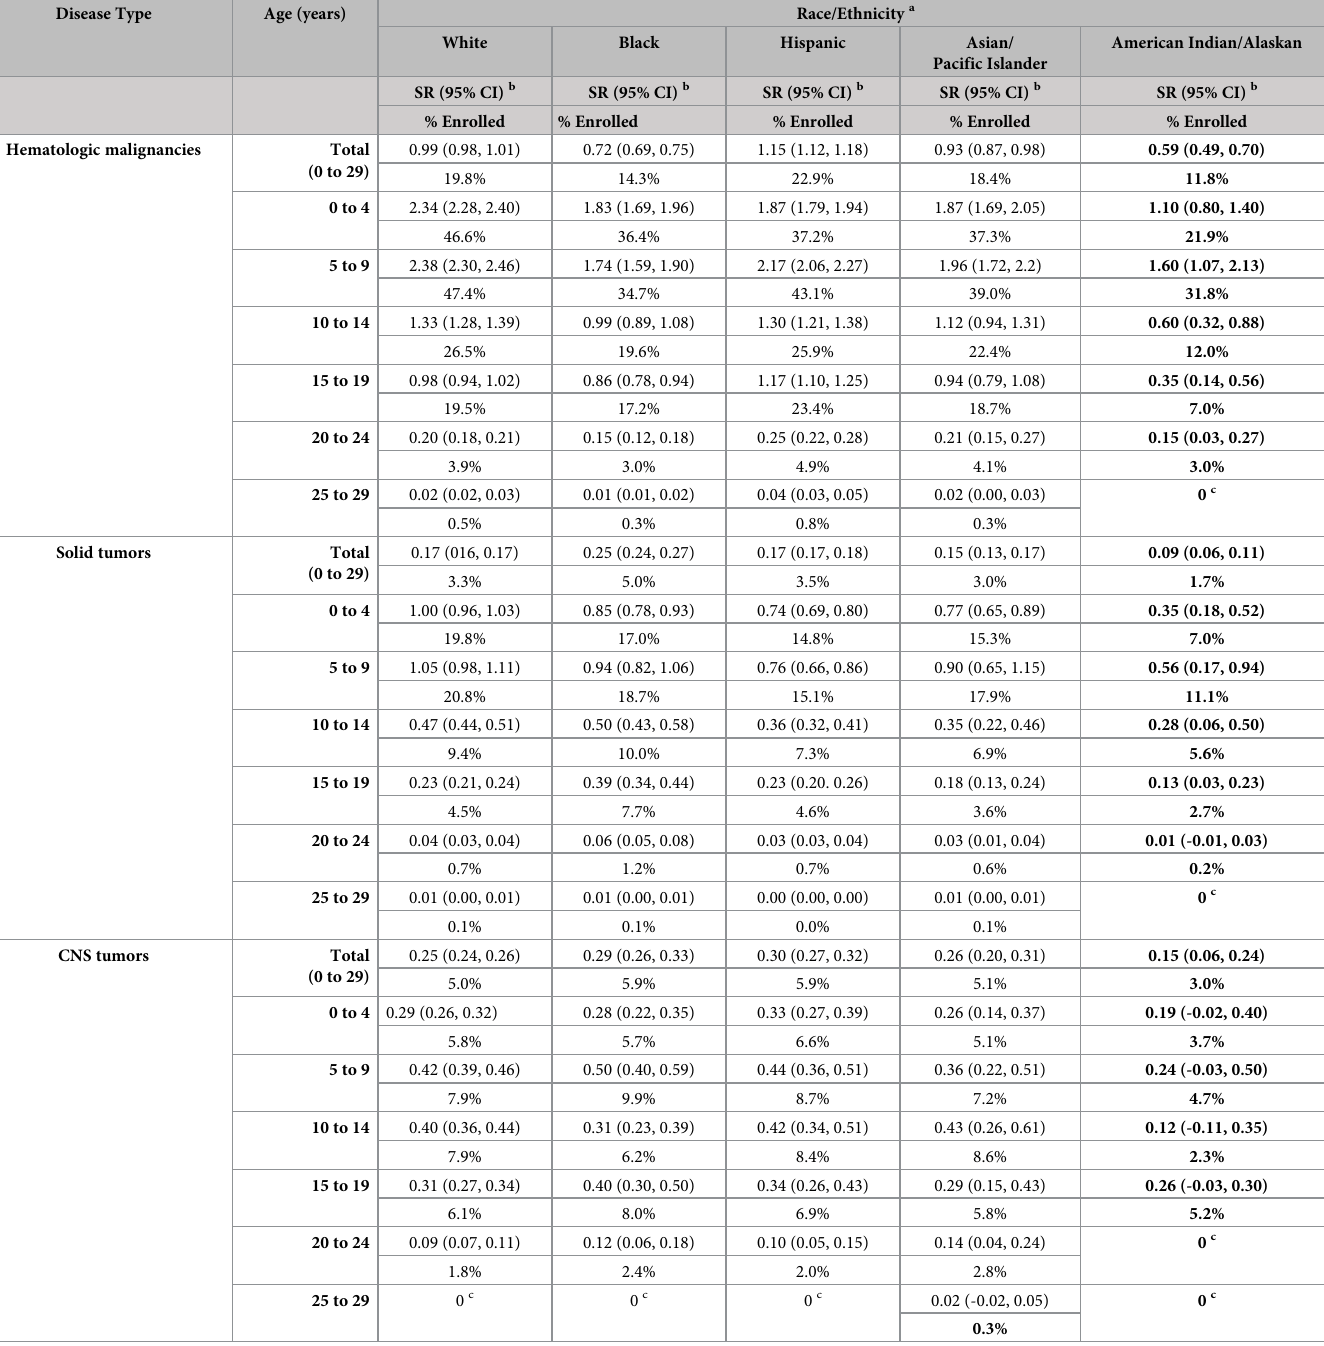
Table 4. COG enrollment stratified by disease type, age, and race, 2004–2015. Disease